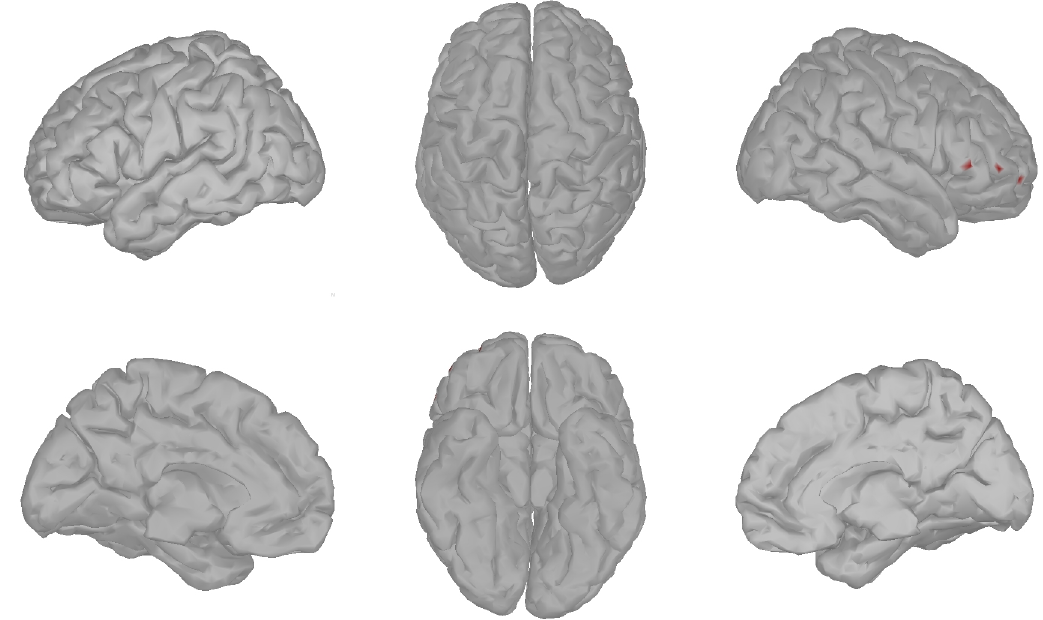
Fig 5. ALS patients: p-value brain map. Color shows voxels with p < 0.05.